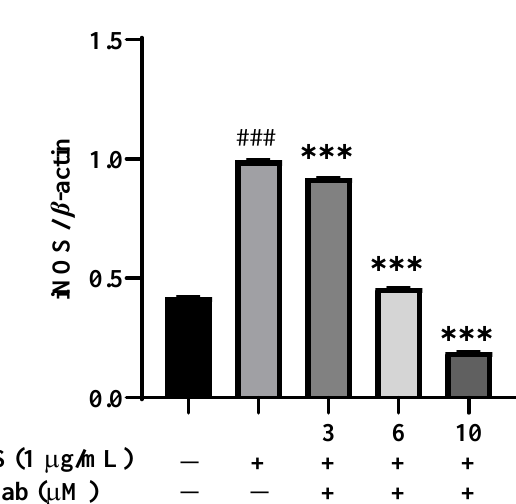
Figure 2. Effect of Tab on neuroinflammation induced by LPS in BV2. After the cells were pretreated with Tab for 4 h, the supernatant was collected after being stimulated by LPS for 24 h. ( A ) The content of NO. ( B ) The protein was extracted. The effect of Tab on the expression of iNOS was detected by Western blot. ( C ) The relative expression of iNOS in ( B ). ### p < 0.001 vs. untreated control cells and *** p < 0.001 vs. LPS-treated cells.